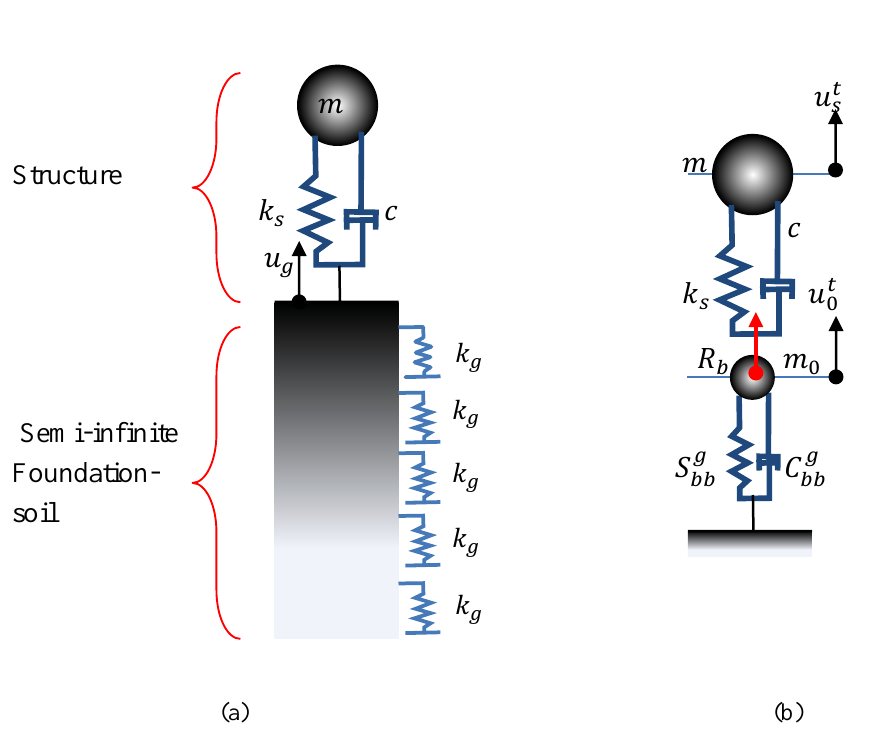
Figure 4. (a) and (b) 2DOF representing mass attached to a semi-infinite rod on elastic